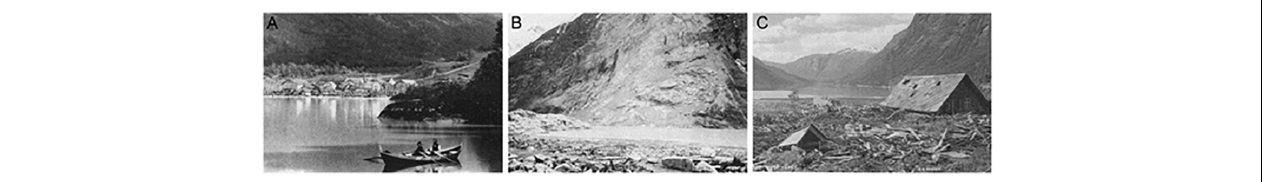
FIGURE 2 | (A) The settlement of Bødal in CE 1890. (B) The Mt. Ramnefjelll slide scar following the 1936 rock fall, with remains of Bødal in the foreground. (C) Remains of the settlement Bødal following the rock fall and tsunami event in CE 1936. Following the two events, the settlement was rebuilt 50 m above its past location in order to avoid destruction from a future event. All pictures are from Martinussen and Berg (1937).